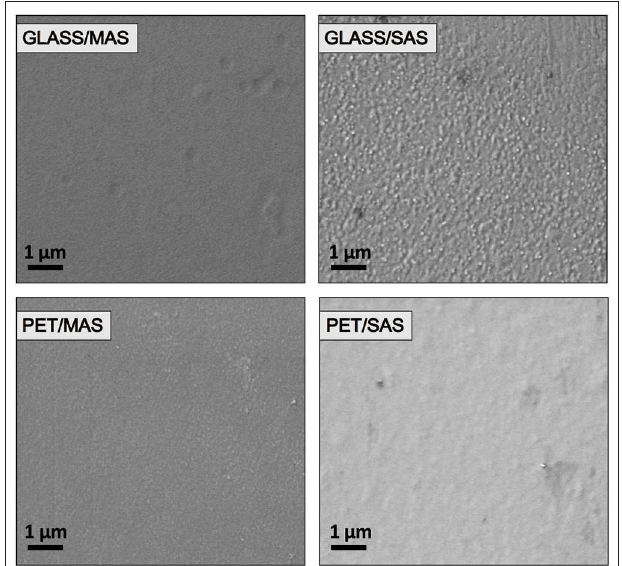
FIGURE 8 | (Above) SEM images of a full device stack fabricated on top of PET/ITO ( Lucarelli et al., 2017) and PET/SnO 2 /Au/SnO 2 (this work), showing that D/M/D electrodes are ultrathin ( ∼ 50nm) as compared to ITO ( ∼ 300nm). (Below) Bending of PET/ITO and PET/SnO 2 /Au/SnO 2 electrodes, with the former bended down to a safe radius of 7mm (diameter of 14mm), and the latter down to 1.5mm curvature radius (diameter of